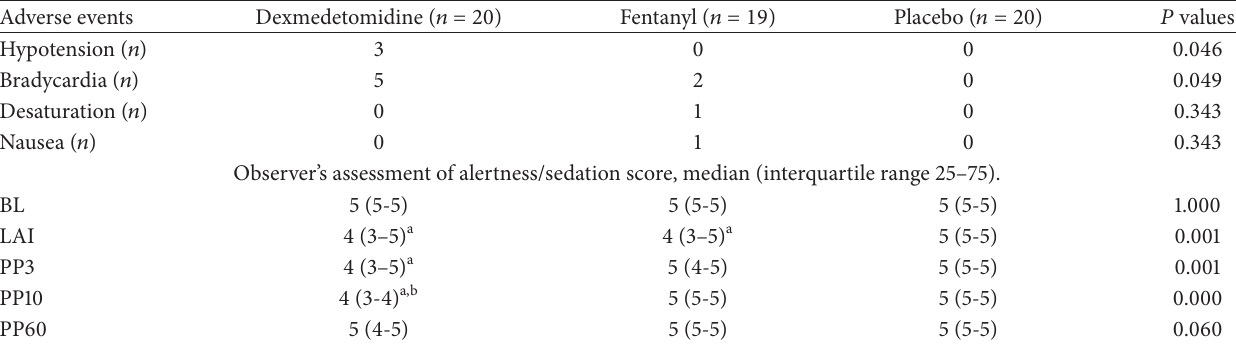
Table 2: Adverse outcomes and sedation score during the study period.